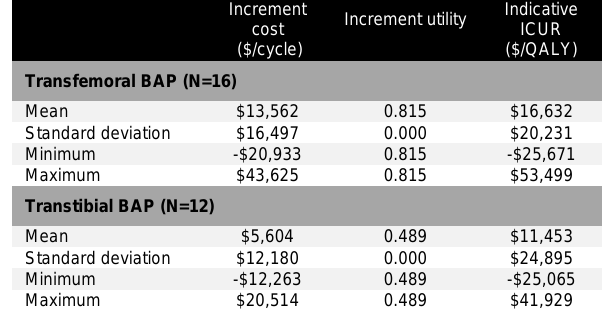
Table 3: Outcome of preliminary cost-utility analyses providing indicative incremental cost-utility ratio (ICUR) based on incremental costs expressed in Australian dollars and utilities expressed in quality-adjusted life-years (QALY) for the provision of transfemoral (2016-2017 prices: 1 Australian dollar ≈ 0.71 Euro ≈ 0.60 British pound ≈ 0.76 US dollar) and transtibial (2018-2019 prices: 1 Australian dollar ≈ 0.63 Euro ≈ 0.54 British pound ≈ 0.71 US dollar) bone-anchored prosthesis (BAP) from Queensland Artificial Limb Service (QALS) prosthetic care perspective (N: Number of consumers). 16,18